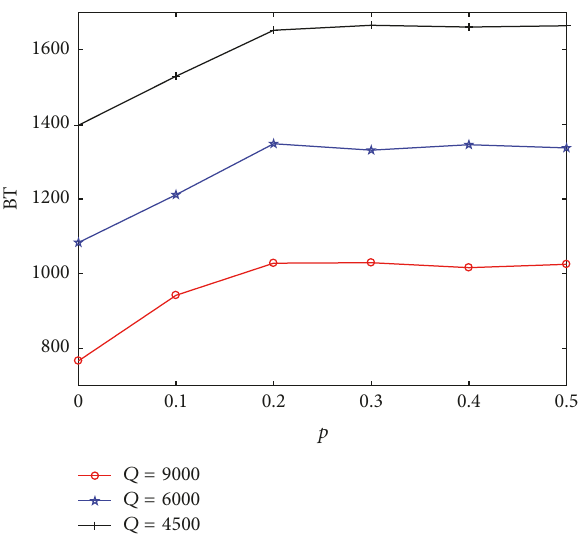
Figure 12: The boarding time under different 𝑄